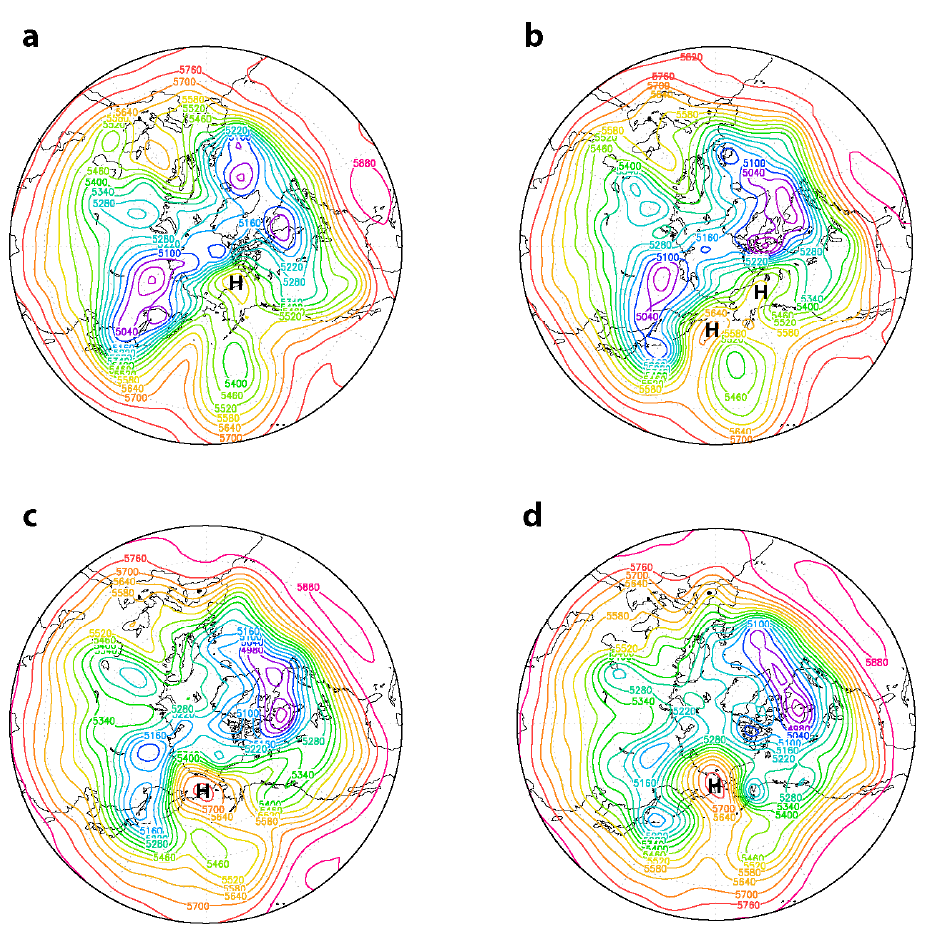
Figure 1. Adapted from [13], the 500 hPa heights derived from the National Centers for Environmental Prediction/National Center for Atmospheric Research (NCEP/NCAR) reanalyses over the Pacific Ocean basin at 1200 UTC for ( a ) 4 February, ( b ) 5 February, ( c ) 6 February, and ( d ) 7 February in 2014. The black ‘H’ in the Pacific Region denotes the block center.